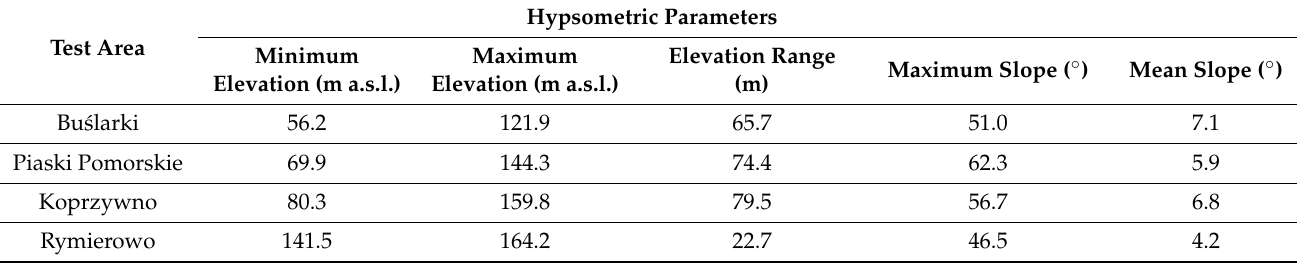
Figure 1. Location of the study area: ( a ) Bu´slarki test area; ( b ) Piaski Pomorskie test area; ( c ) Koprzywno test area; ( d ) Rymierowo test area. Table 2. Hypsometric characteristics of the test